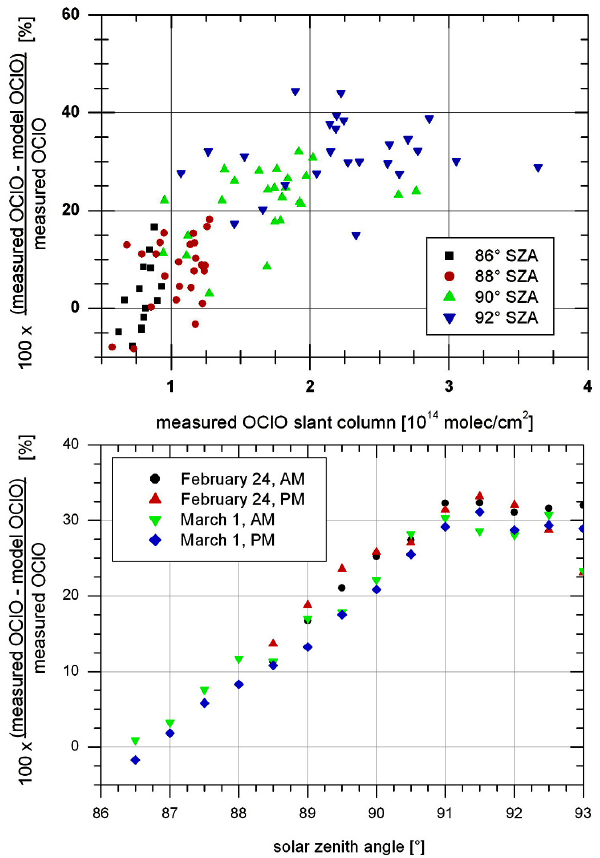
Fig. 7. The relative differences between modelled OClO columns and ground-based data for Ny- ˚Alesund as a function of OClO (top) and SZA (bottom). Top: all data from 24 February until 8 March as given in Fig. 6 colour-coded for the four different solar zenith angle bins. Bottom: differences for two selected days as stated in the embedded box. The relative differences between modelled and measured OClO increase with chlorine activation as well as with